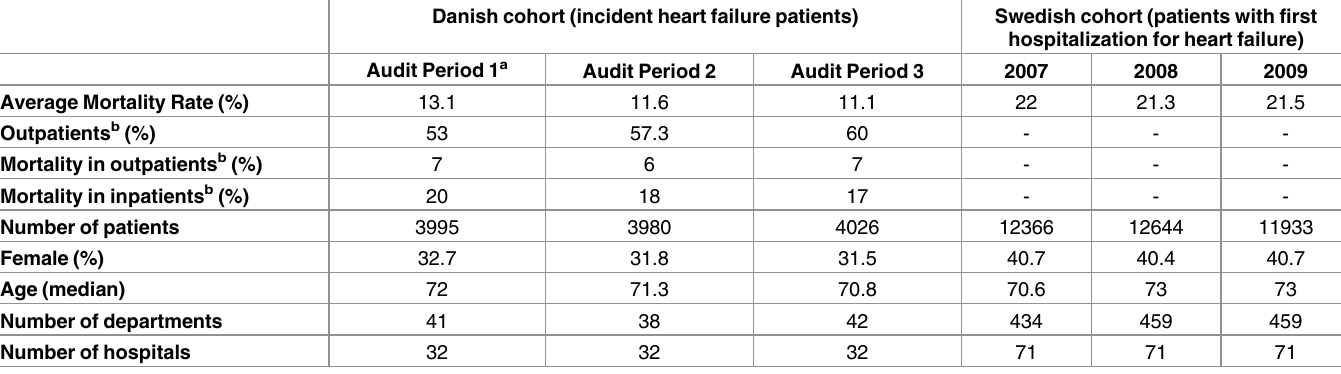
Table 1. Crude national mortality rates, number of heart failure patients, metricson gender and age, and hospital departments included in the